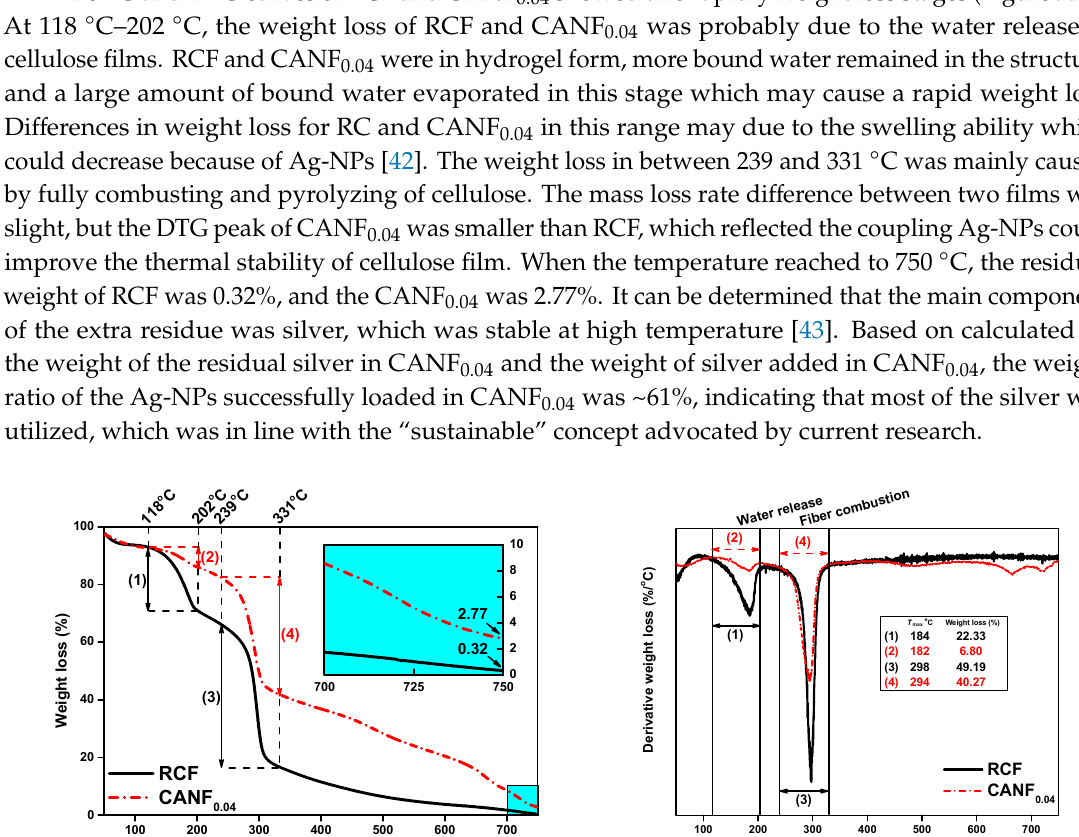
of RCF and CANF 0.04 .